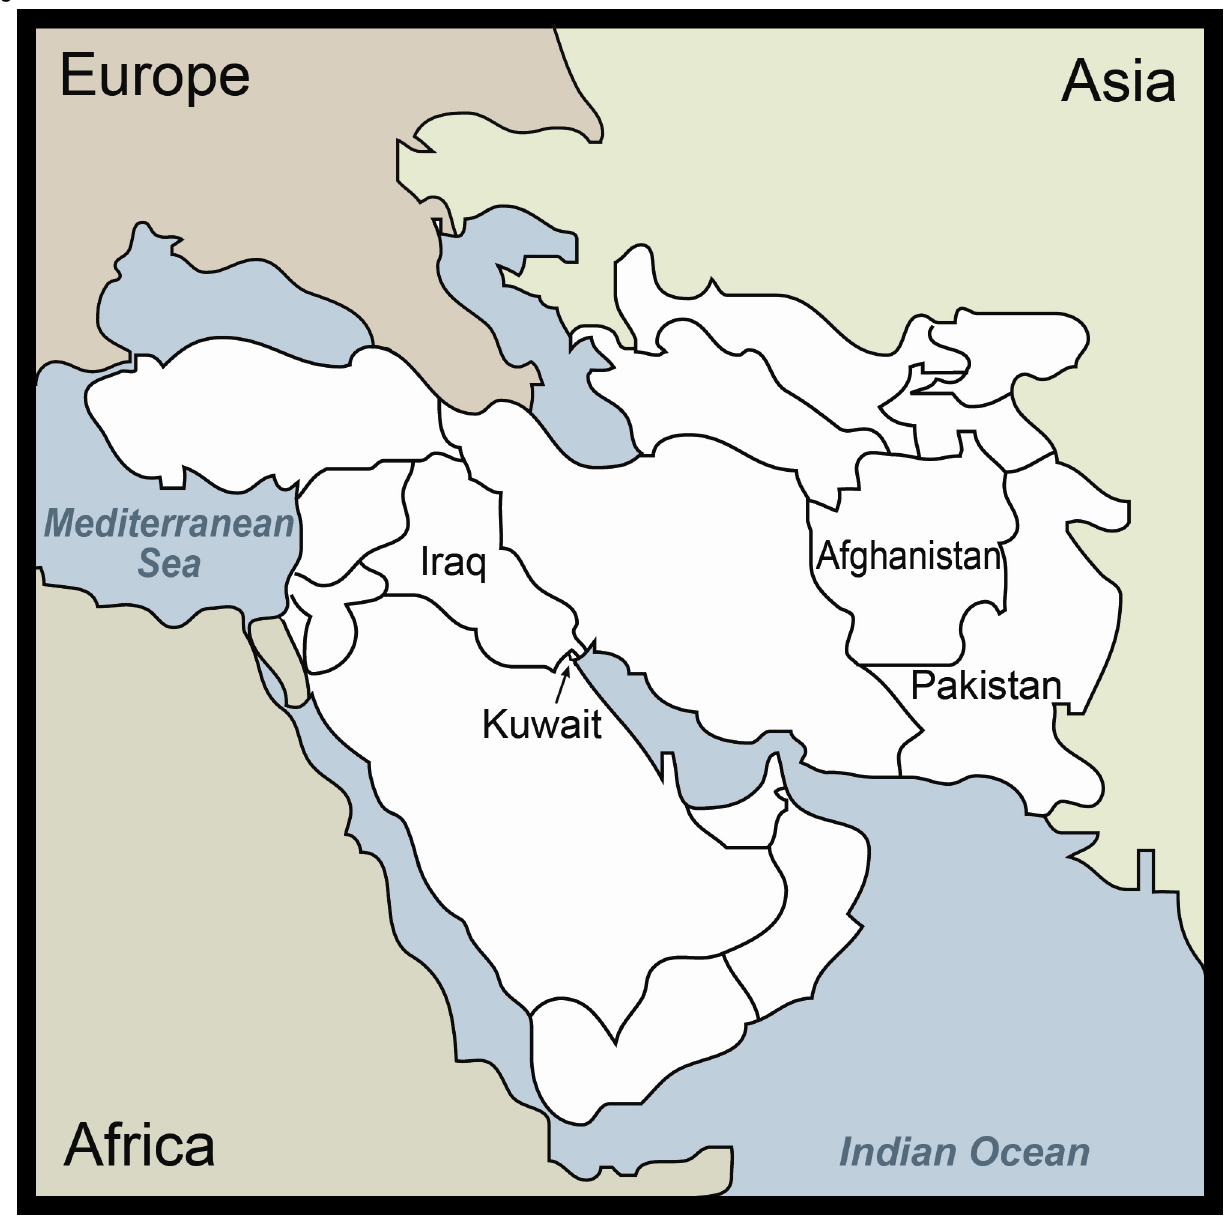
Figure 1. Middle Eastern countries with email telemedicine